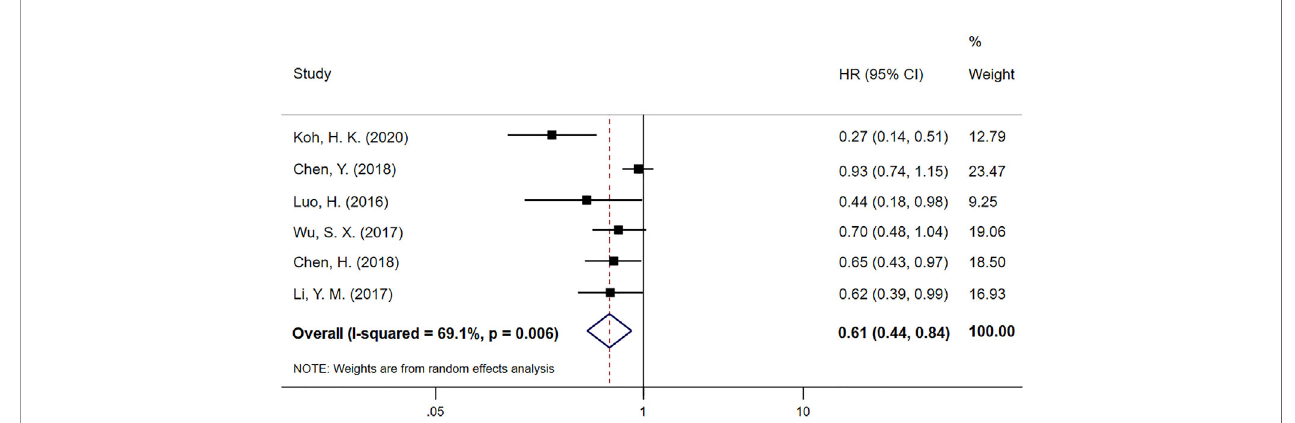
FIGURE 3 | Meta-analysis of the associated HRs of PFS for CCRT – CCT compared with CCRT alone. HR, hazard ratio; PFS, progression-free survival; CCRT – CCT, consolidation chemotherapy following concurrent chemoradiotherapy; CCRT alone only concurrent